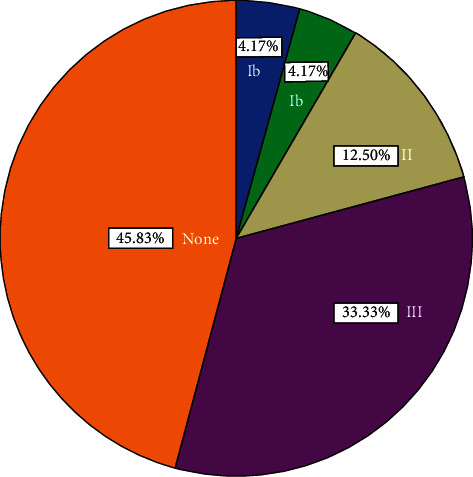
Percentage distribution of GBS serotypes (Ia, Ib, II, and III) of S. agalactiae based on cps genes as indicated.